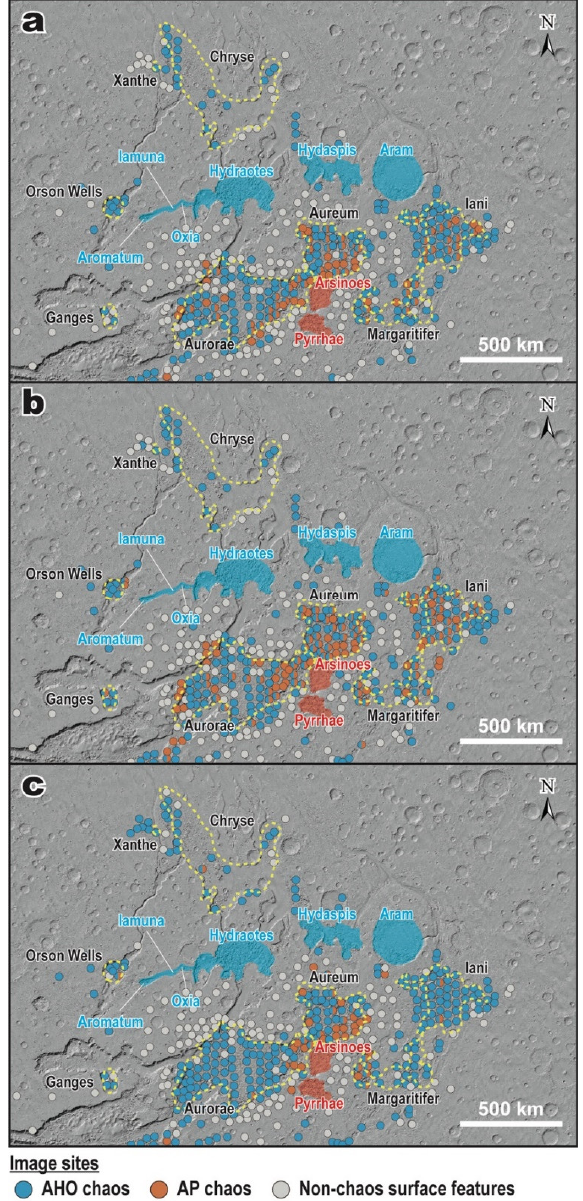
Figure 12. Classification results of chaos blocks (locations shown by circles) for the circum-Chryse outflow channels chaos region based on the ( a ) CTX, ( b ) THEMIS, and ( c ) MOLA classifiers. Orange and blue shaded areas represent regions whose images were used as training data for the AP and AHO chaos blocks, respectively. Regions within yellow dotted lines represent chaos terrains.